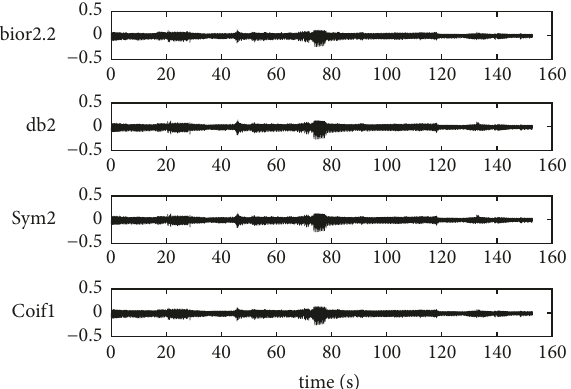
Figure 9: Detail coefficients of the direct method with different